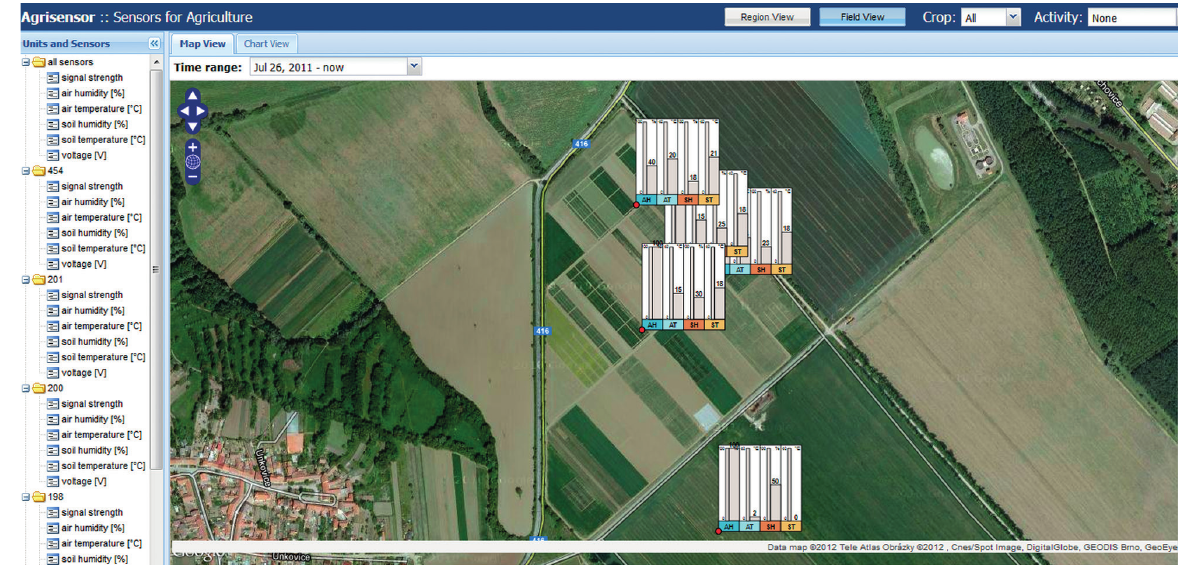
Fig. 1. Spatial visualization window showing experimental field with location of all sensor